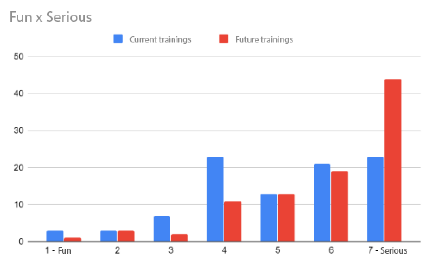
Figure 5. Vision of electricians and instructors about current and fu- ture trainings: fun x